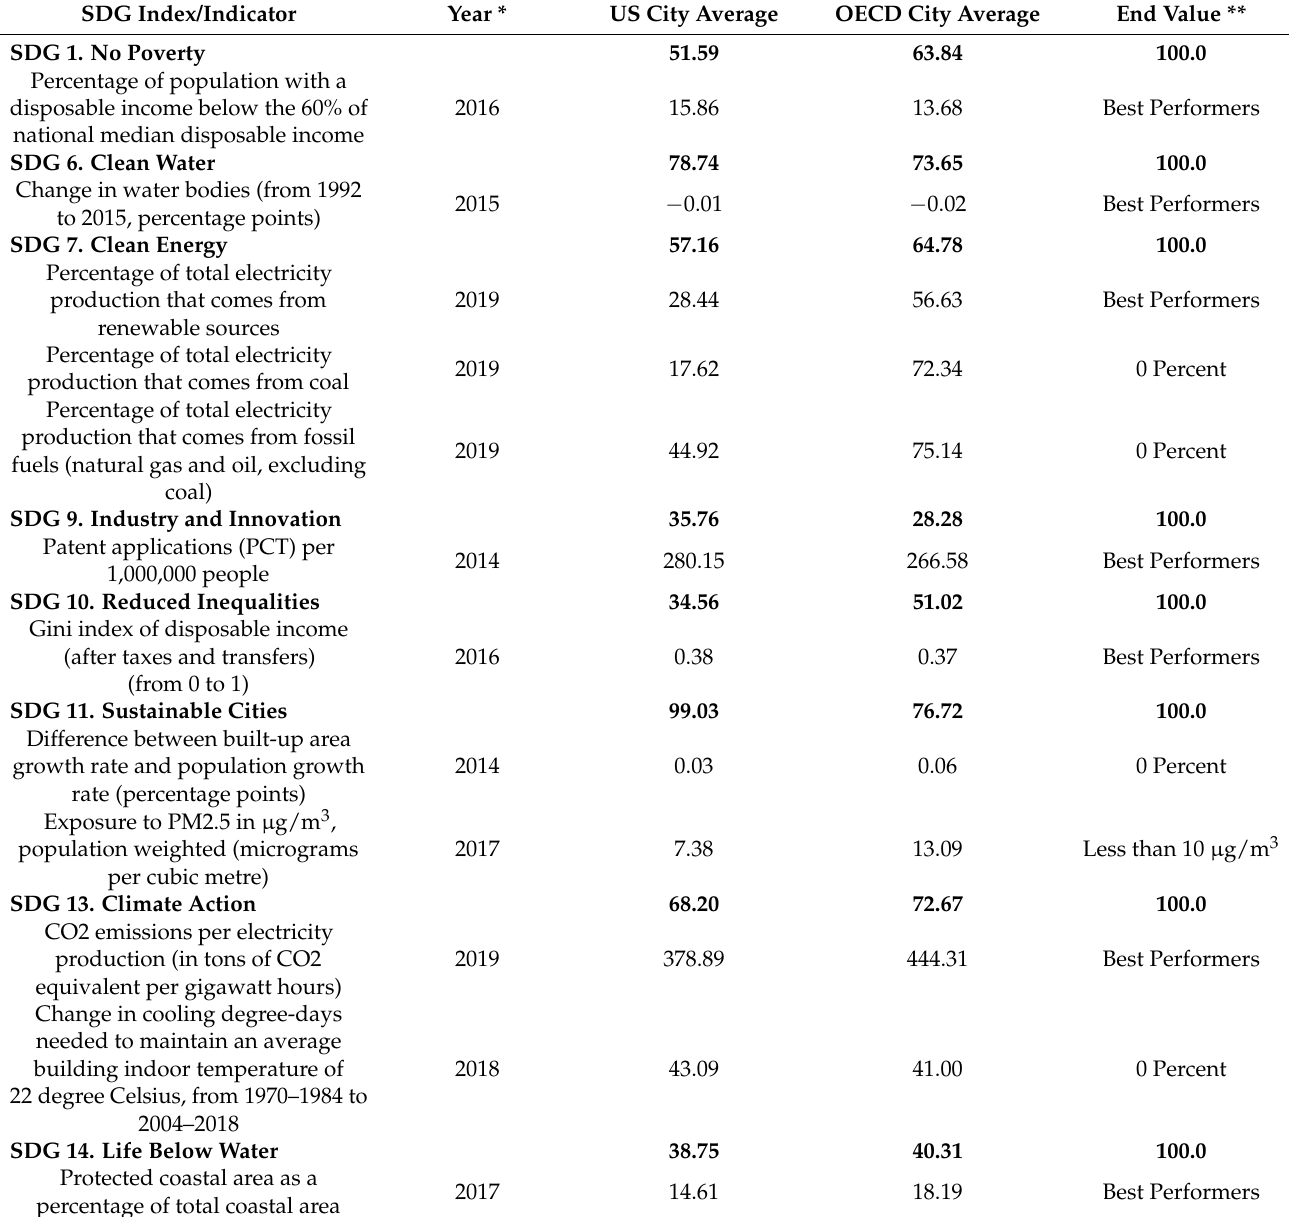
Table A1. Average Scores for OECD City Indicators in the U.S. and OECD. Source: Authors calculations from OECD data [20]. Data download, extracted 19 August 2021. * Average year in the indicator for the sample of cities. ** The suggested end value to be achieved by 2030. When end values are not inferable from the UN framework, the OECD defines end values based on the knowledge of experts in the field, or alternatively, based on the best performance of cities in that indicator. For the latter, OECD estimates an unweighted average using the top performer in each country. For each SDG, the first row represents the percentage of the SDG goal attained based on the component indicator(s); subsequent rows report the indicator(s) used to assess goal attainment and their average